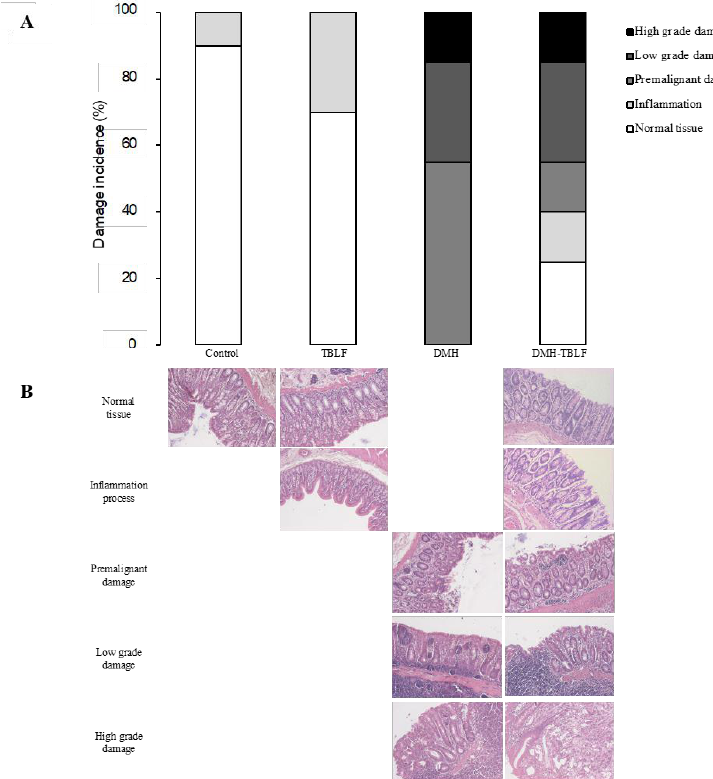
Figure 3. Histopathological analysis for colon lesions provoked by DMH and treated with TBLF. Rats were administered DMH for eight weeks for the development of cancer lesions followed by intra-gastric administration of TBLF (50 mg/kg) on alternate days for six weeks. ( A ) Incidence of colon tumors. ( B ) Hematoxylin-eosin histopathological analyses of colon lesions (10×). Microphotography shows the histological changes where it can be observed that tissue architecture was disrupted according to the malignancy.